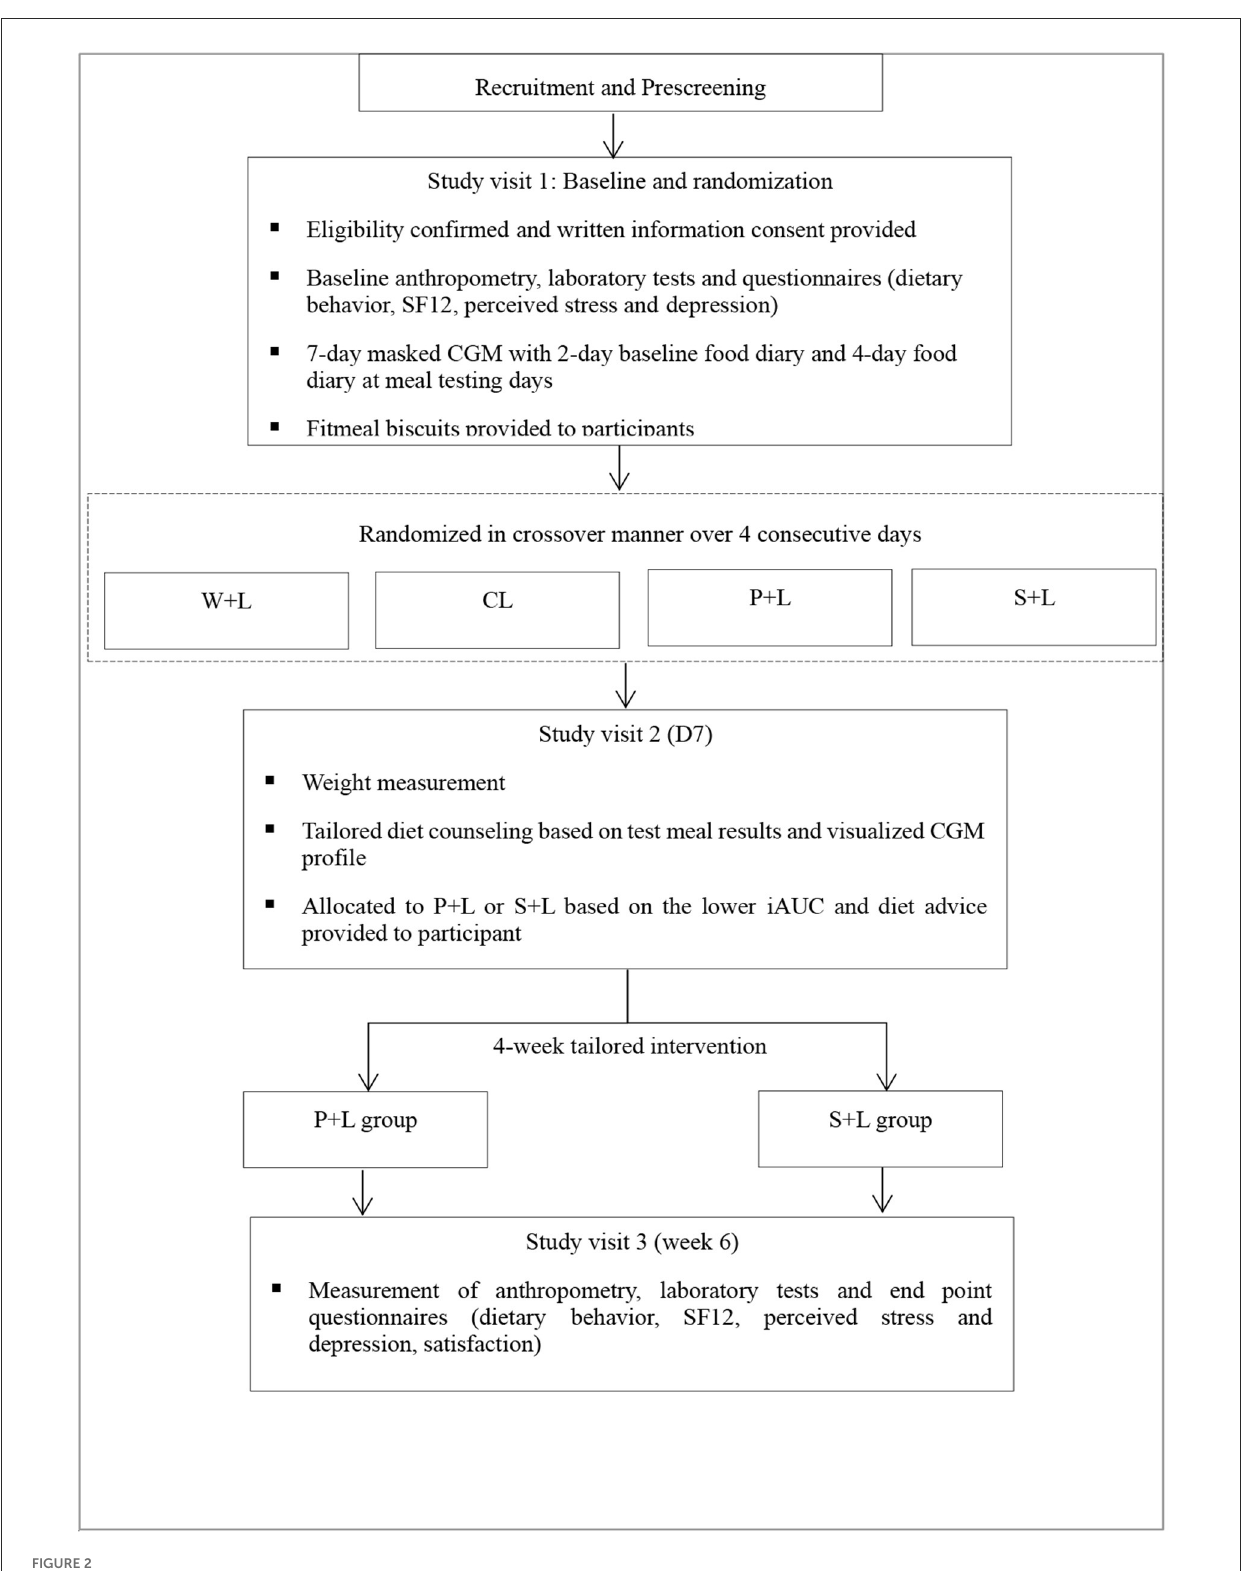
FIGURE2 Study design flow chart.